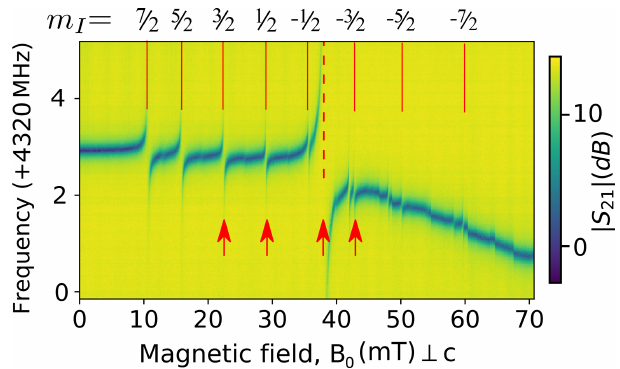
Figure 6. Spectroscopy of Er 3 + : CaWO 4 . Transmission coeffi- cient | S 21 | ( ω ) at 100mK as a function of the magnetic field B 0 applied along to the a crystalline axis, around 4 . 323GHz. Verti- cal red lines indicate the expected erbium transitions either for the I = 0 isotopes (dashed) or the I = 7 / 2 isotope (solid). Red arrows indicate the field at which the ESEEM data are measured.